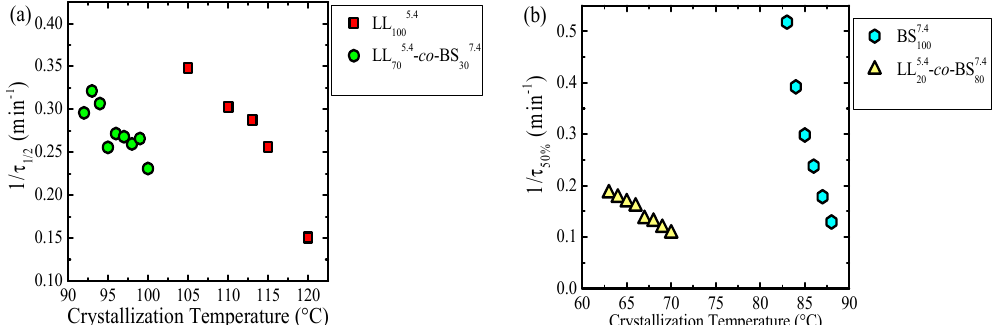
Figure 4. Overall crystallization rate (1/ τ 50% exp ) versus crystallization temperature ( T c ) for ( a ) PLLA homopolymer and PLLA blocks within the LL 705.4 - mb -BS 307.4 copolymer; and ( b ) PBS homopolymer and PBS blocks within LL 205.4 - co -BS 807.4 copolymer.